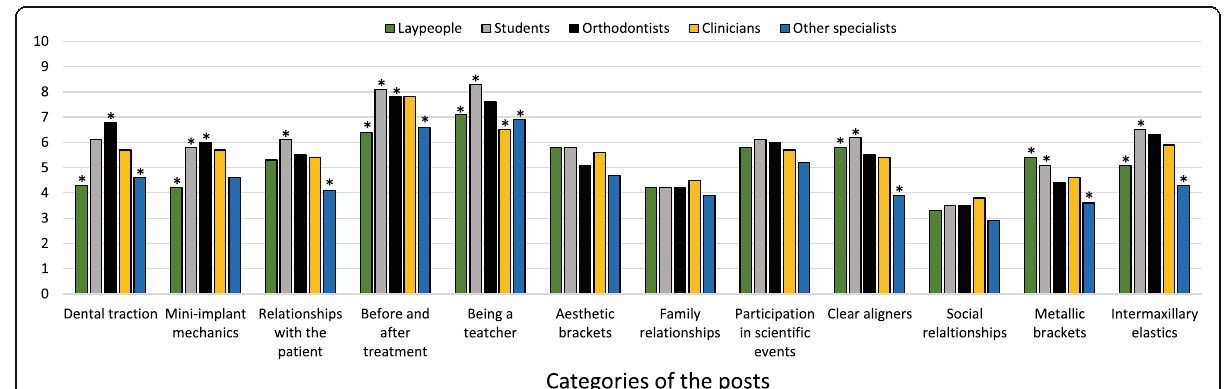
Fig. 2 Distribution of the mean score for perception of credibility between groups, according to the different categories of the posts. Asterisk indicates statistical